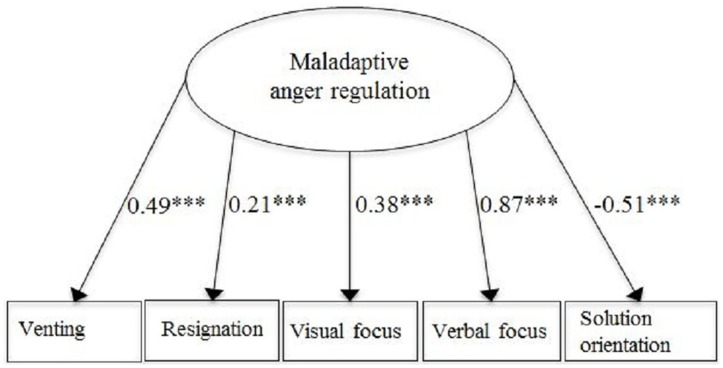
Latent factor of maladaptive anger regulation (standardized path coefficients). ***p < 0.001; N = 599; Model fit: χ2(3) = 8.33, p = 0.04, RMSEA = 0.05, SRMR = 0.02, CFI = 0.99.